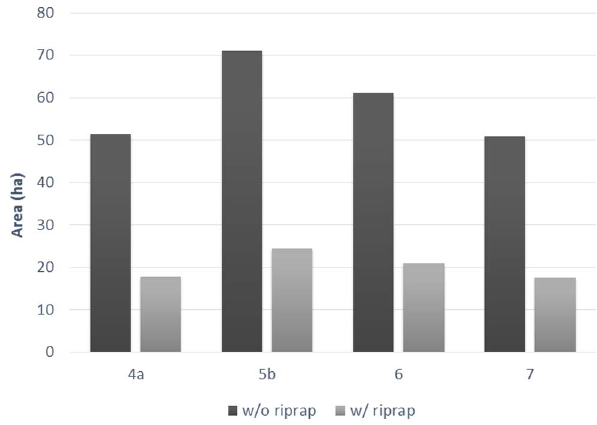
Figure 3. Predicted floodplain reworked by lateral channel migration lost to flow regulation (NODOS scenario flows compared to NODOS base flow) and riprap. These areas represent the area of potential mitigation for the NODOS project. Riprap reduced almost three times (2.89) the area compared to the proposed NODOS flow regulation.